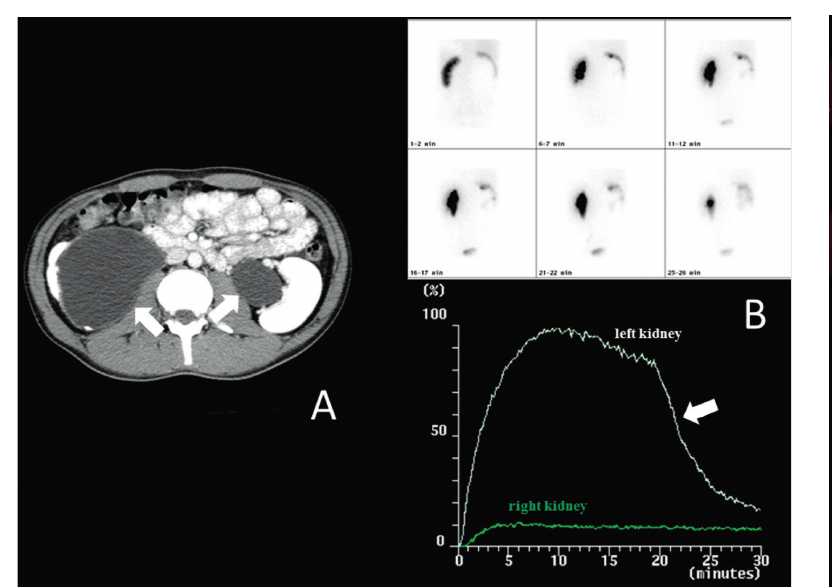
Fig. 8. Residual splenic tissue identified by [Tc-99m] white blood cells in a patient with treatment-resistant idiopathic thrombocytopenic purpura, despite a previous splenectomy.